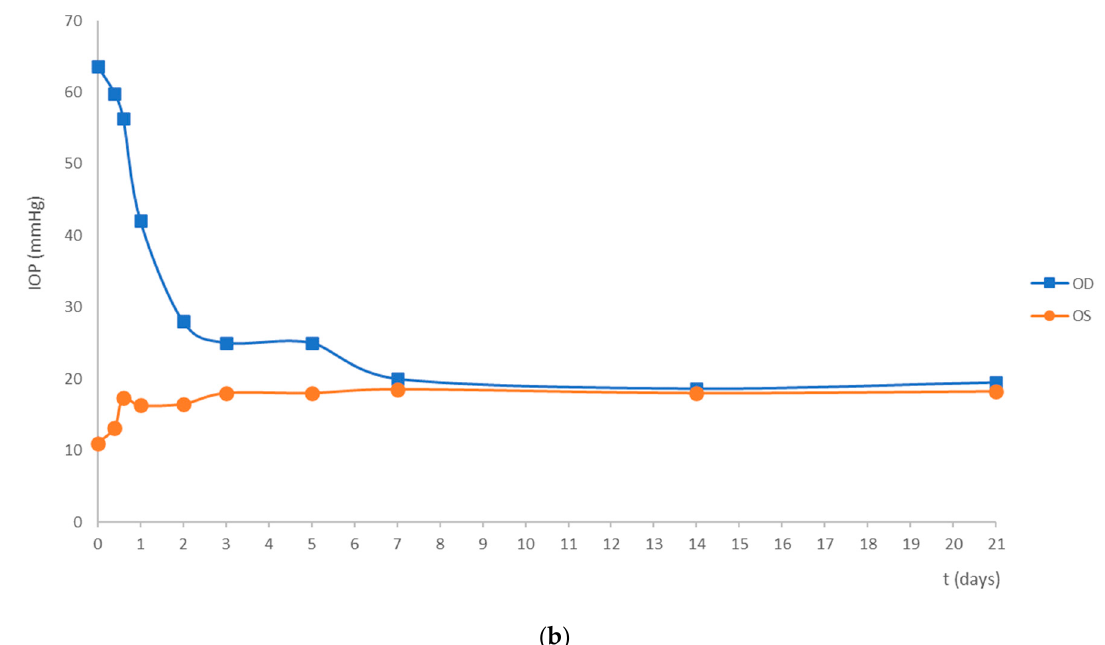
Figure 2. Mean IOP from the OD (orange) and from the OS (blue) since the day of glaucoma induction (t = 0) until 21 days later, in the treatment ( a ) and the control ( b ) groups. Time is presented in days in the X axis and IOP is presented in mmHg in the Y axis.